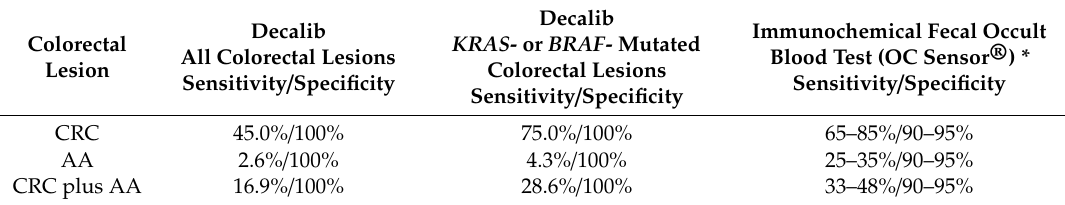
Table 5. Sensitivity and specificity of ctDNA and immunochemical fecal occult blood test in detection of colorectal